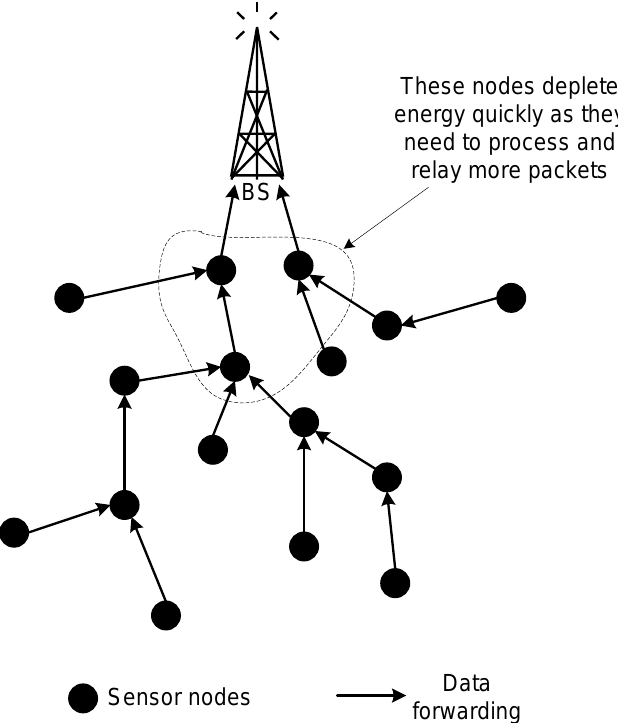
Figure 1. Uneven energy dissipation by sensor